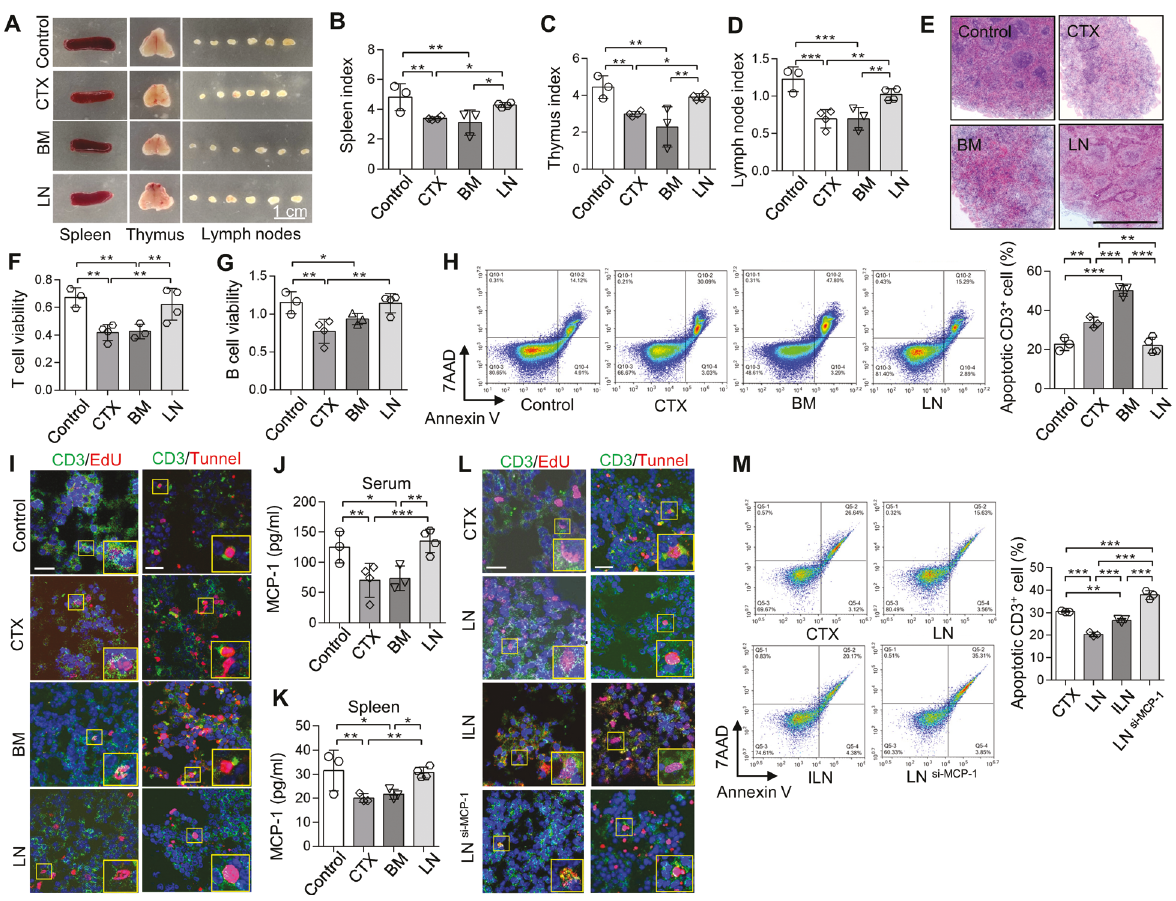
Fig. 6 LNMSCs rescue immunosuppressed phenotypes in CTX-induced mice. A The morphology of immune organs (spleen, thymus and lymph nodes) decreased in CTX-induced immunosuppressed mice, and recovered after treatment with LNMSCs. Scale bar = 1 cm. B – D The immune indices of the spleen, thymus and lymph nodes decreased in CTX-induced immunosuppressed mice, and recovered after treatment with LNMSCs. n = 3 – 4 ( B – D ). E The pathological changes of spleens in CTX-induced mice. Scale bar = 1 mm. F , G CCK8 assay showed the viability of T cells and B cells of spleens recovered after treatment with LNMSCs. n = 3 – 4 ( F , G ). H The apoptotic rate of CD3 + T cells in the spleen decreased after treatment with LNMSCs and increased after treatment with BMMSCs. n = 3 – 4. I Immuno fl uorescence staining showed LNMSCs promoted the proliferation of T cells in spleens, while BMMSCs exhibited opposite effects. LNMSCs suppressed the death of T cells in spleens, while BMSCs induced it. Scale bar = 20 μ m. J , K ELISA analysis showed MCP-1 signi fi cantly increased in serum and spleens of LNMSC- treated CTX-induced immunosuppressed mice. n = 3-4 ( J , K ). L , M Immuno fl uorescence staining and fl ow analysis showed I-LNMSCs and LNMSCs pre-treated with MCP-1 siRNA increased T-cell apoptosis and failed to promote T-cell proliferation in spleens of CTX-induced